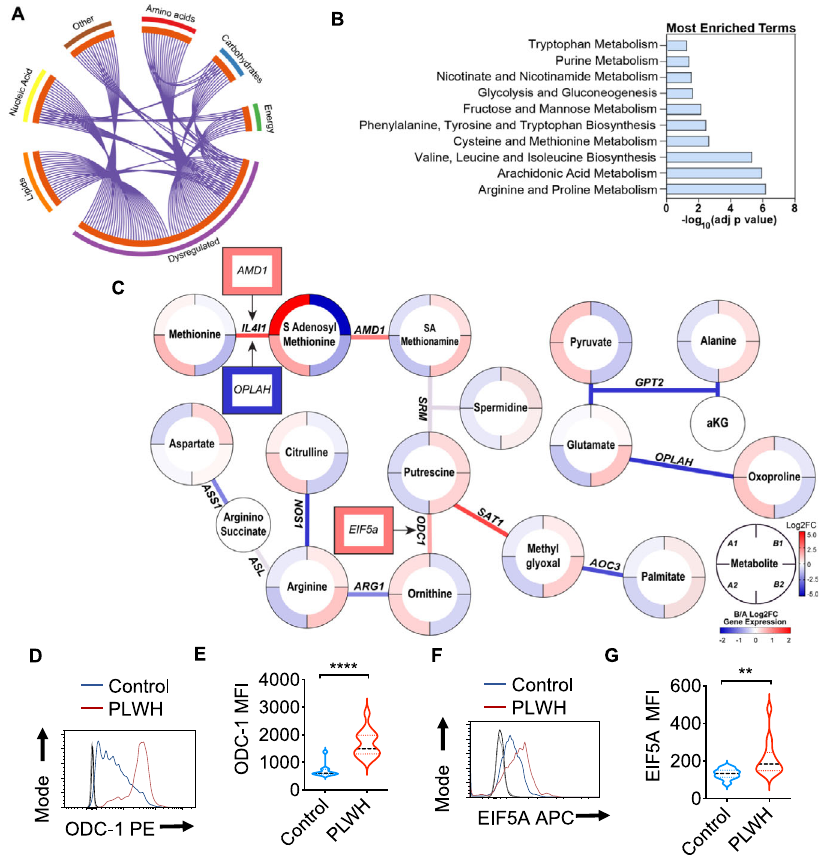
Fig. 1 | Salivary metabolome analysis in conjunction with transcriptome and fl ow cytometry analysis of gingival immune cells. Metabolite levels were determinedbyLC-MSinsalivasamplesfromhealthycontrols(GroupA)and PLWH (Group B) (uninfected controls n =26; PLWH; n =40). Genes are mapped to path- ways (Kegg, GO, Reactome), and the algorithm calculates the fold change and p - value between how many hits were input and how many hits would be expected from random chance. Log10 adjp-value indicates the signi fi cance of each term compared to random chance, larger values indicate higher likelihood that the pathwayistruly enriched.Pathways are analyzed individually with no comparisons made. A Circosplotlinkinggenessigni fi cantlydysregulatedbetweengroupsAand B (purple outer ring) to their associated KEGG pathways viapurpleline.Graph was generated viaMetascape. B Overallthemostenrichedterms by-log10pvalue were generated using dysregulated genes and metabolites via Metaboanalyst 5.0. C Genes andmetabolites associatedwiththe most enriched term, Arginine proline